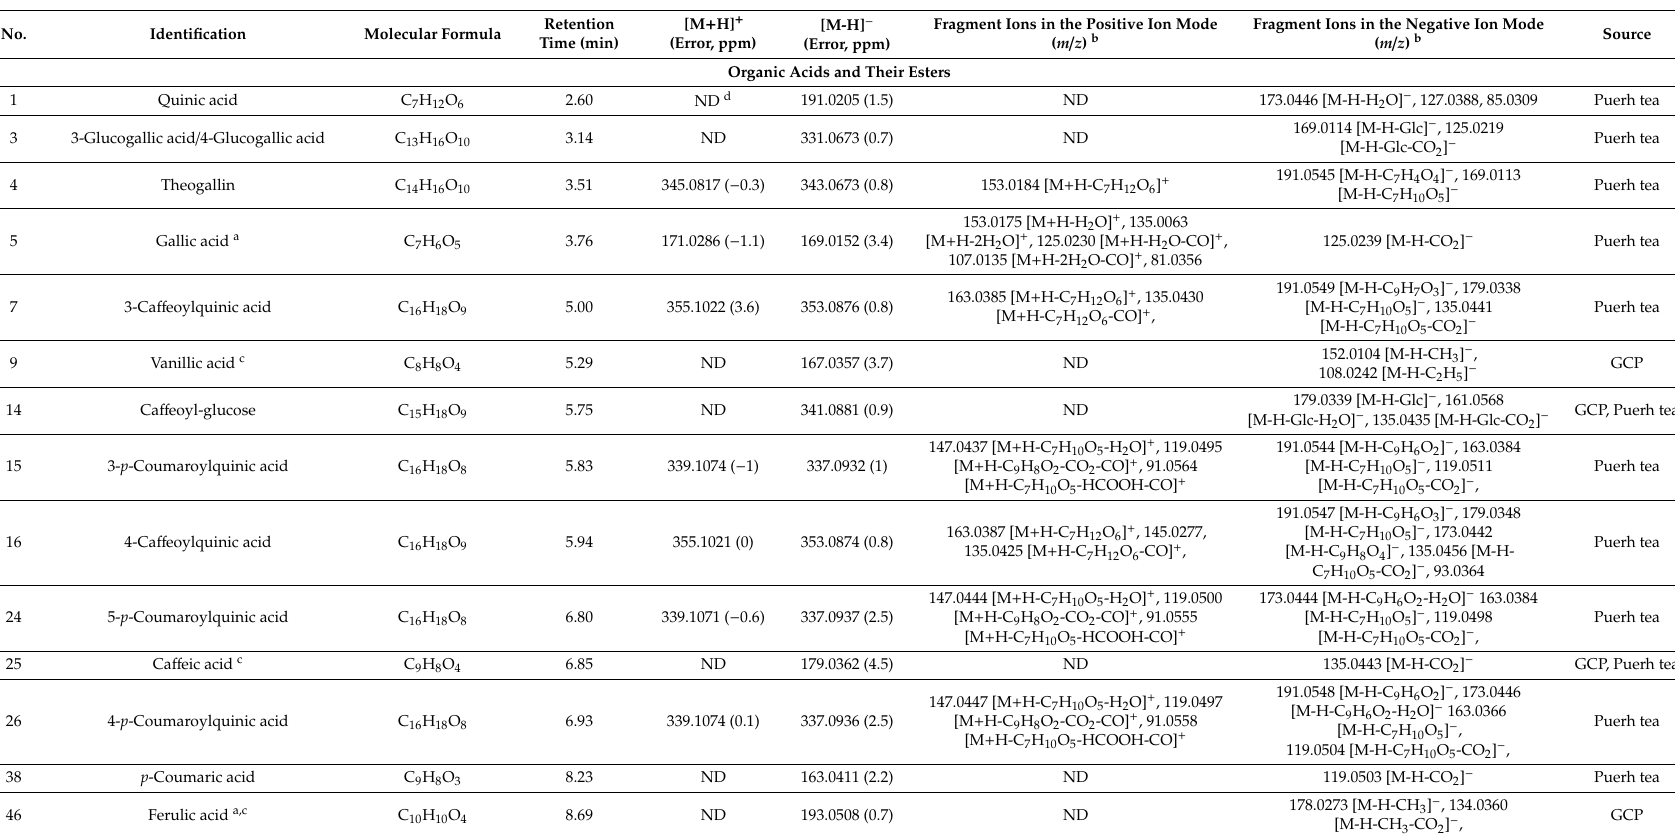
Table 1. Identification of the chemical compounds of Ganpu tea by ultra-high performance liquid chromatography / quadrupole-time-of-flight tandem mass spectrometry (UHPLC-Q-TOF-MS /